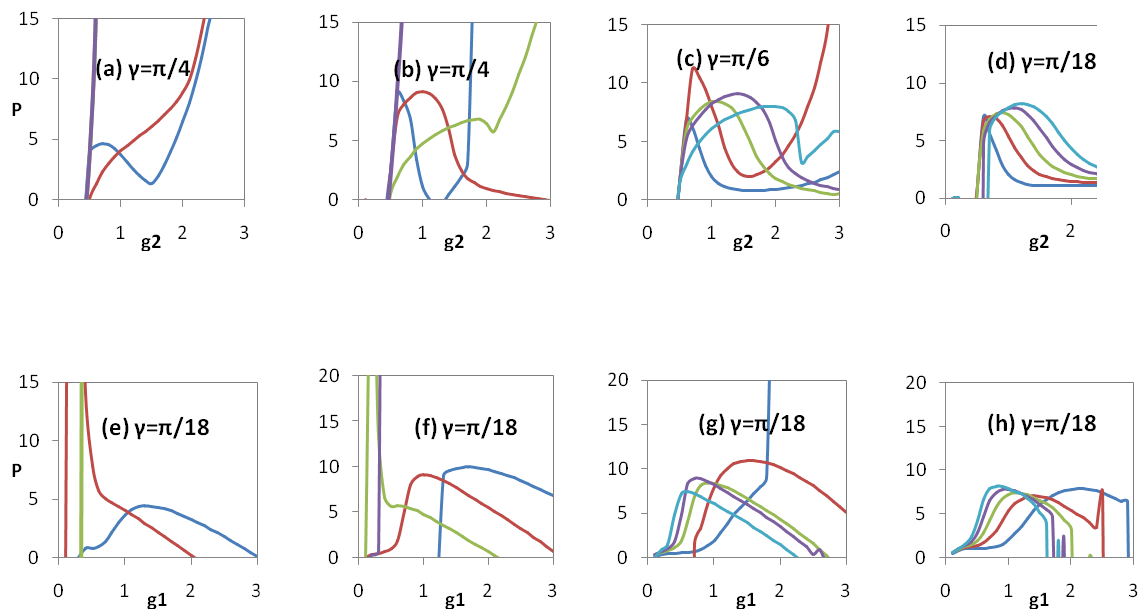
Figure A.1: (Same as Fib2 but with full form of strain energy function). Zero normal and shear stress boundary condition. µ =5kPa, k 1 =1, k 2 =0.2. A/B = 0.5. c 5 =0.01. (a-d) Critical buckling pressure P plotted against circumferential growth rate g 2 for various buckling mode. (e-h) Critical buckling pressure P plotted against radial growth rate g 1 for various buckling mode.